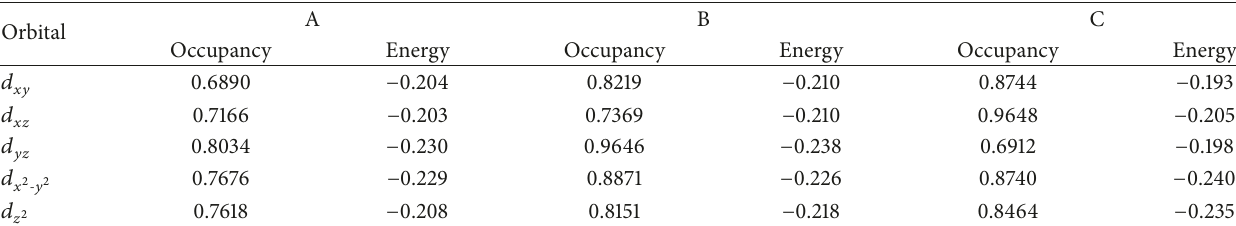
Table 4: The 3d-orbital occupancy and energy of the central vanadium ion in the various complexes.